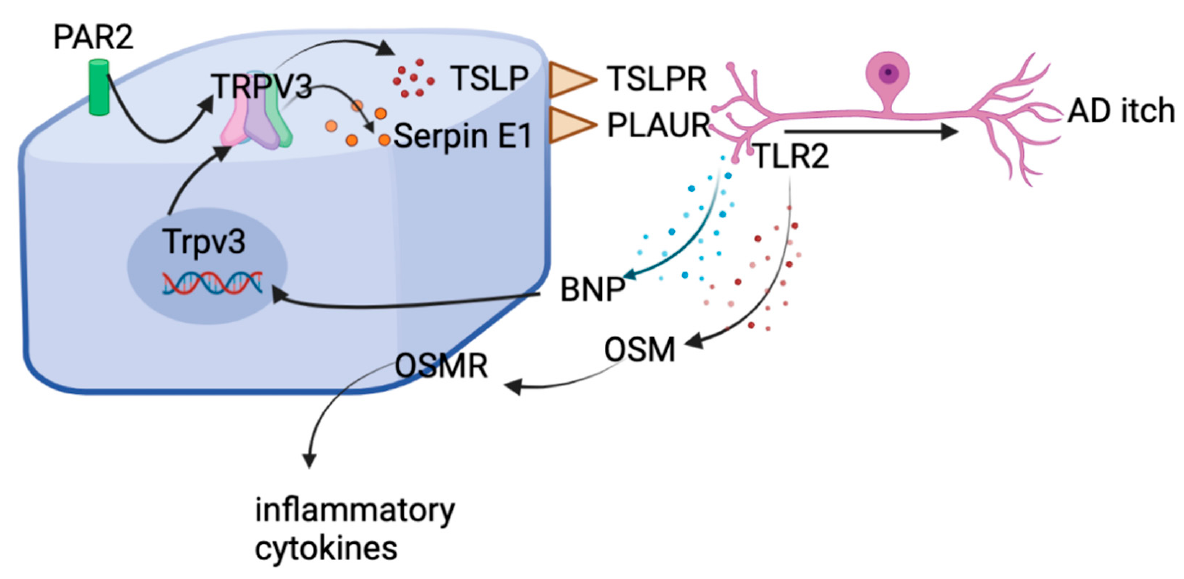
Figure 4. Epidermal PAR2/TRPV3 signaling cascade plays a key role in AD pruritus.